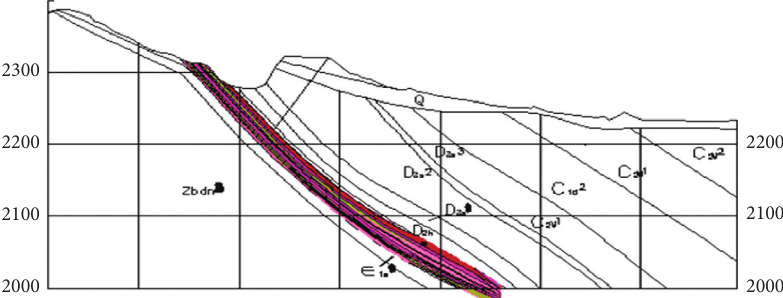
Figure 1: Plane stress modeling experimental frame.